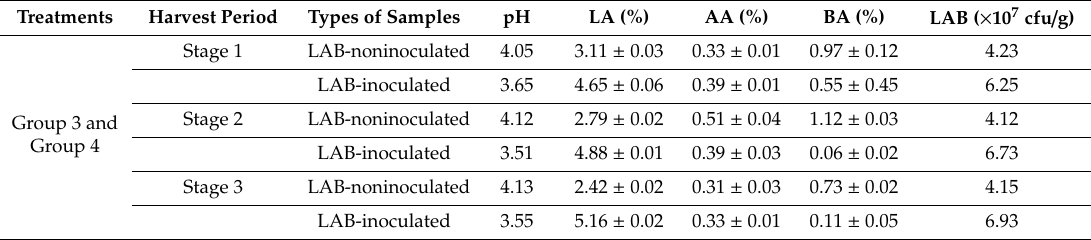
Table 4. pH, organic acids, and microbial count analyses of LAB-inoculated and non-inoculated WCR silage